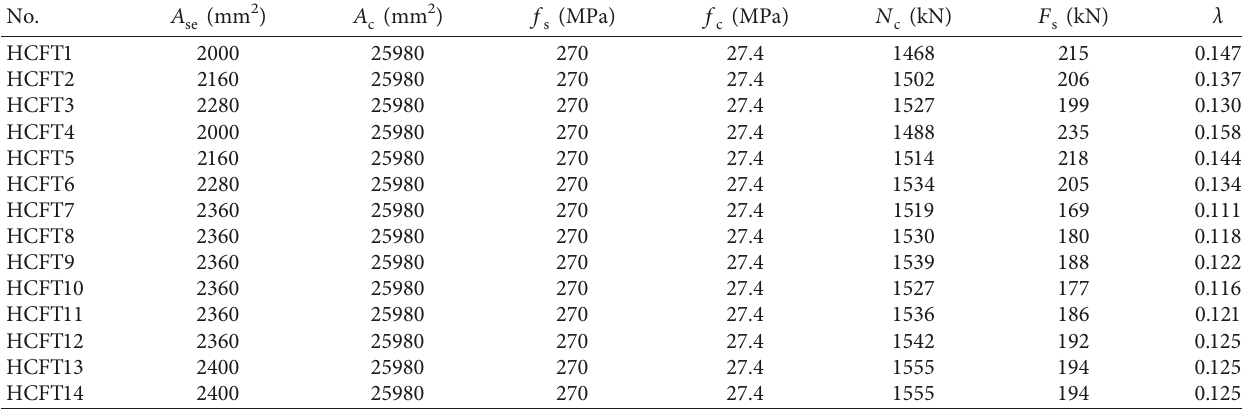
Table 2: Confinement factor for all the notched